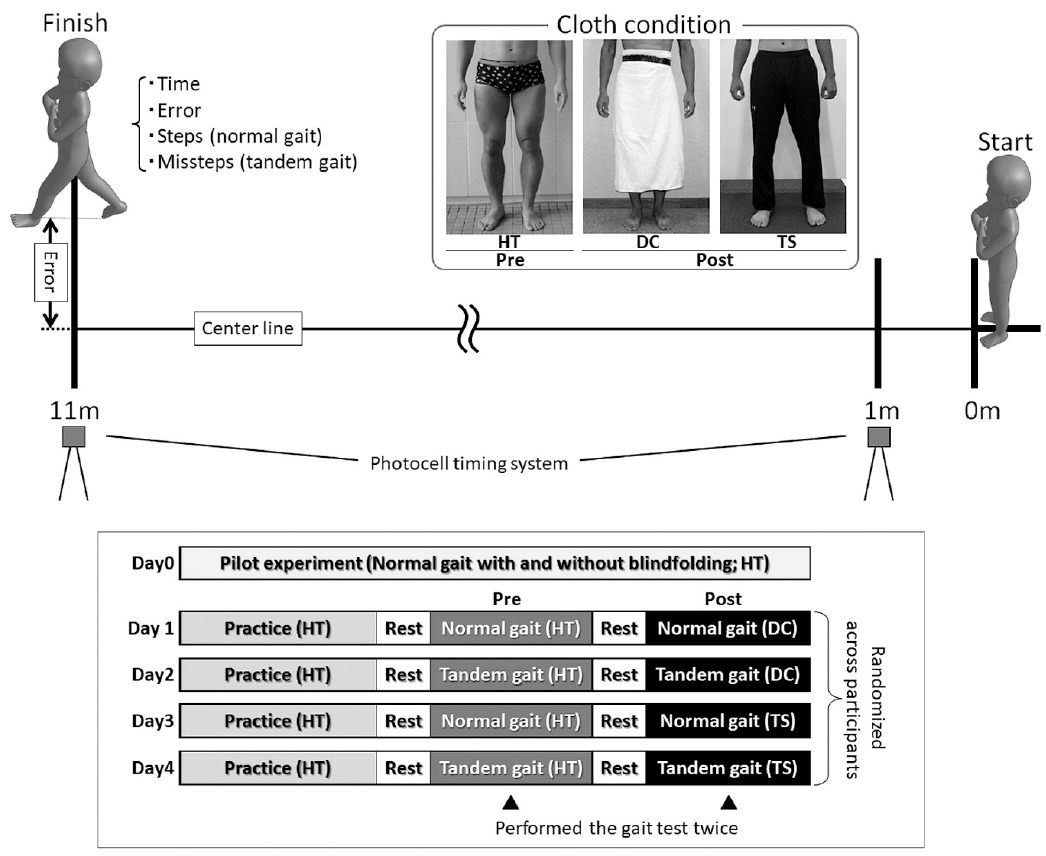
Figure 1. Schematic of the experimental protocol.